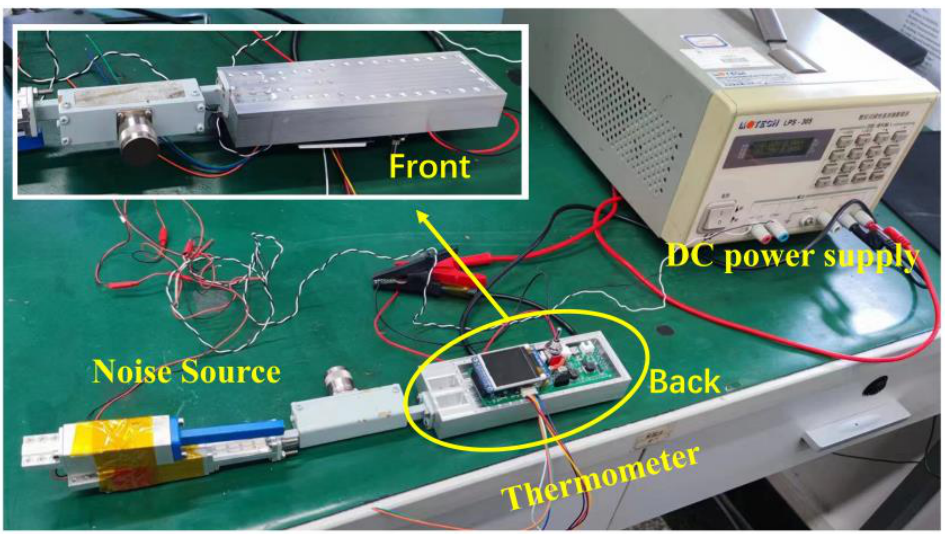
Figure 19. The test site of the thermometer. Figure 20a shows the measurement results of the thermometer output voltage at 12 different equivalent noise temperatures, and ten measurements are completed at each equivalent noise temperature to determine the fluctuation of the thermometer output voltage at a fixed input temperature. Then, the variation in the average output voltage of the thermometer with the equivalent input noise temperature is shown in Figure 20b, and the standard deviation of the thermometer output voltage is shown in Figure 20c. It can be seen that the standard deviation of the thermometer is less than 0.6 mV at all input